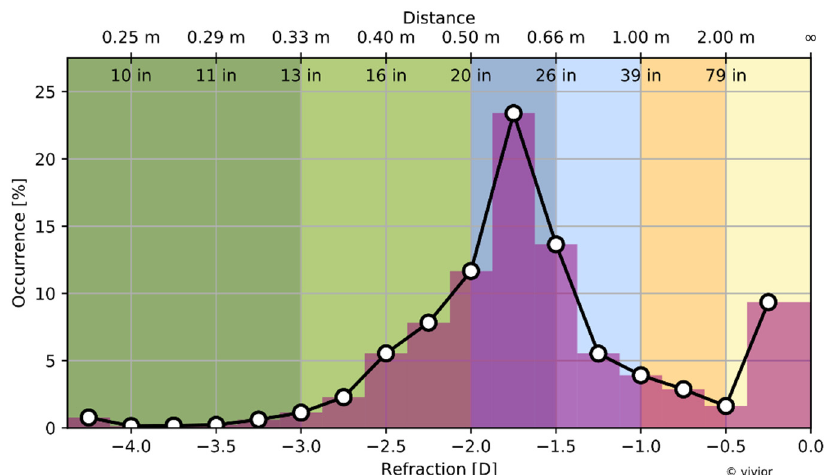
Figure 2. Distribution of viewing distance and required additional optical power of the eye (refraction) to observe objects of visual activity. The plot demonstrates domination of the intermediate viewing distance related to the computer work at around − 1.75 D (0.57 m) for the particular patient (Patient A). Color coding is used to display the viewing zone, with green representing near viewing distances, blue representing intermediate, and yellow representing far.